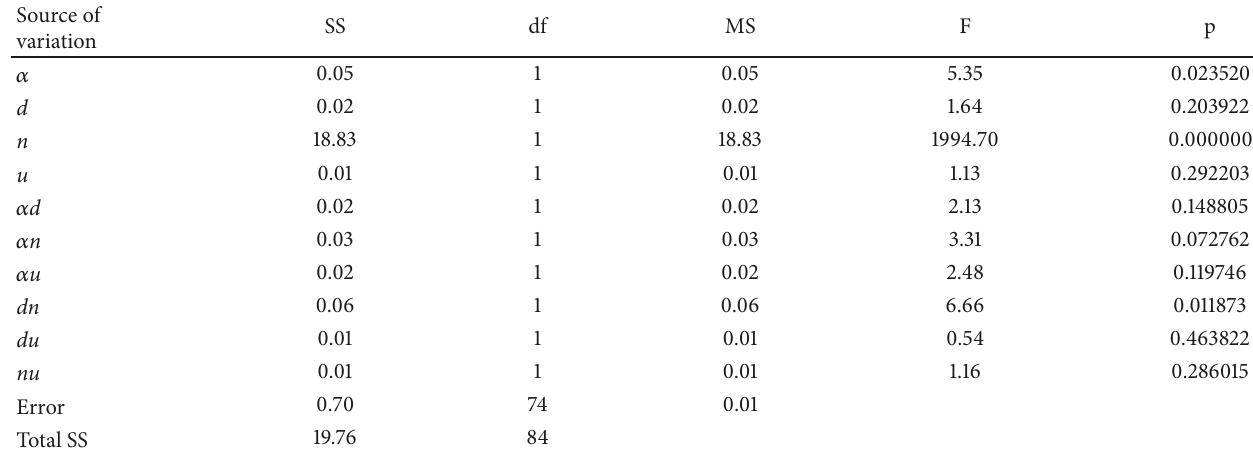
Table 3: Analysis of variance results of the model of polymer pressure p, where the coefficient of determination and its corrected value are equal to R 2 ≈ R 2 adj =0.96. SS: sum of squares, df: number of the degrees of freedom, MS: mean sum of squares, F: values of the test statistic, p: value of probability corresponding to the test statistic